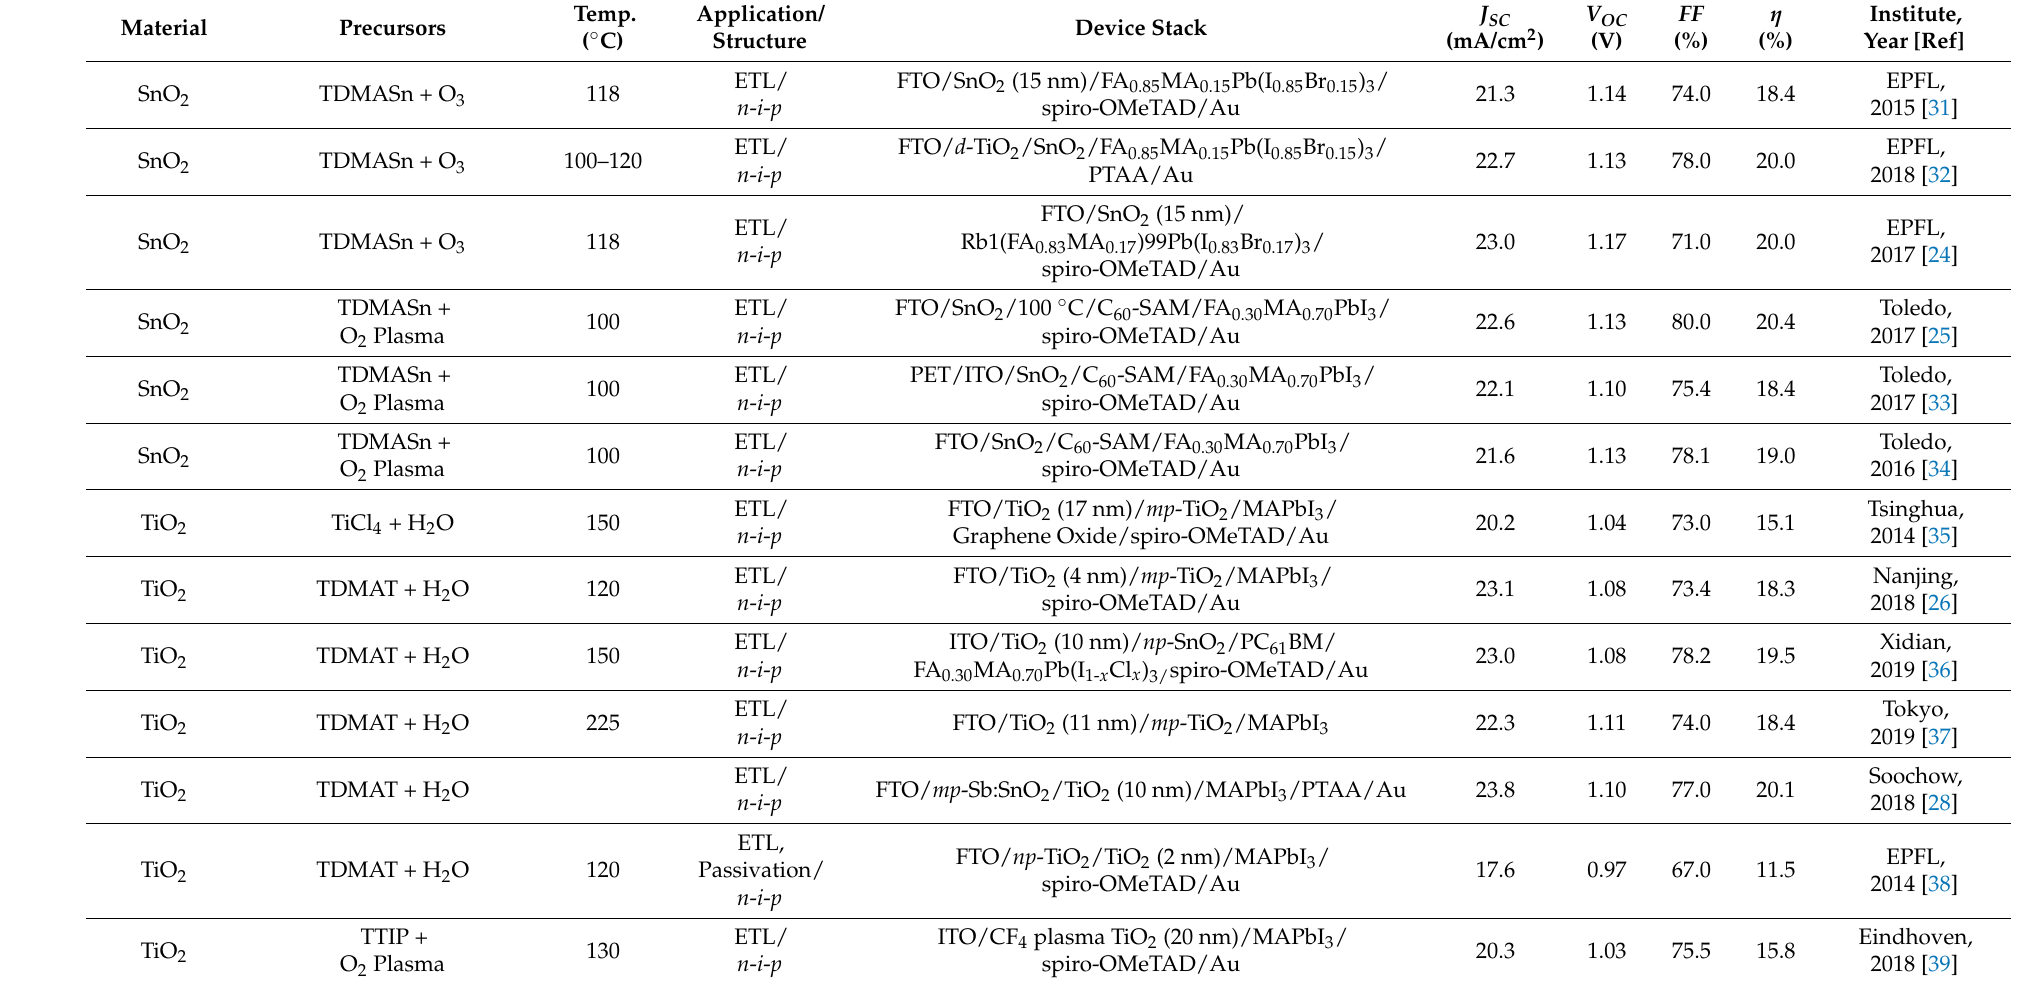
Table 1. Summary of literature on ALD-grown layers below the absorber in perovskite solar